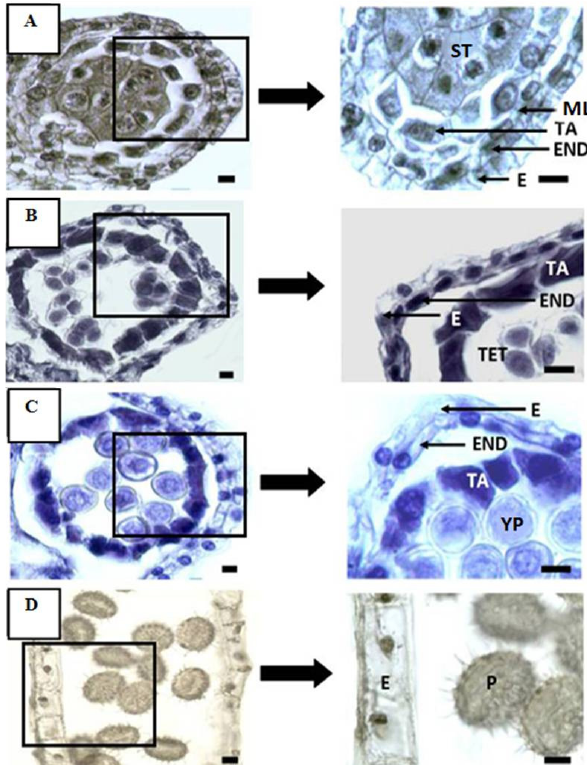
Fig. 5. H. annuus L.’ s anthers stained with Coomassie brillant